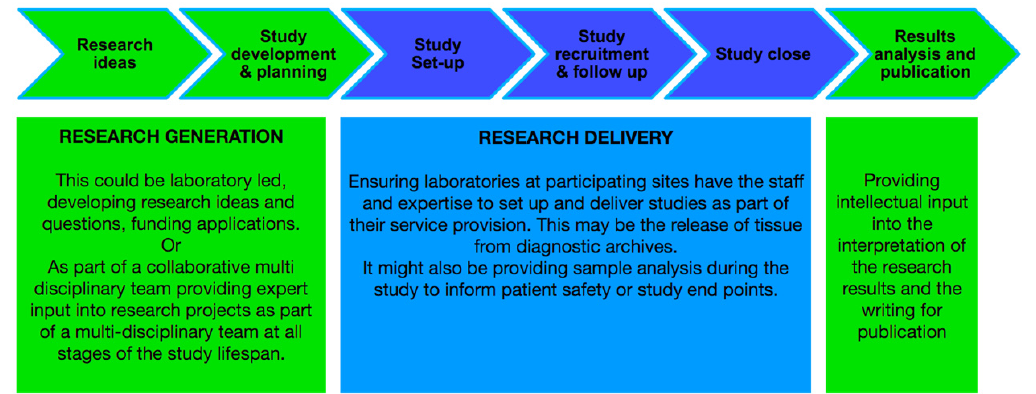
Figure 1. Involvement of pathology along the research study pathway. The pathology laboratory has different potential functions along the study pathway. Pathologists may be leading the Research Generation (green), e.g. coming up with the research question, applying for funding, writing up the research or providing pathology expertise to these activities as part of a multidisciplinary team. Pathologists may also be responsible for providing supporting Research Delivery activities (blue) for studies from outside researchers, e.g. assessing research protocols for local delivery and providing service activities such as reporting on or arranging the release of diagnostic tissue to research